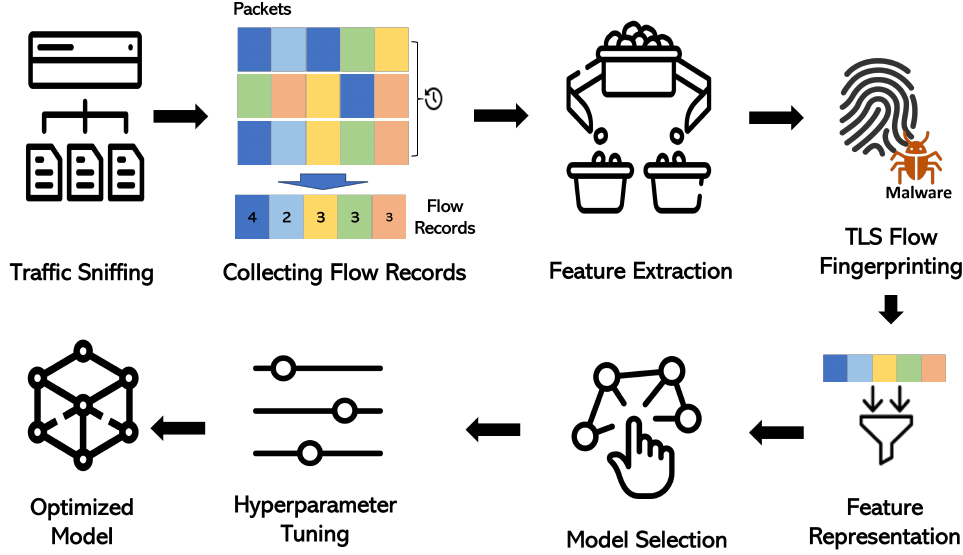
Figure 4. Machine learning pipeline for passive inspection of TLS-encrypted